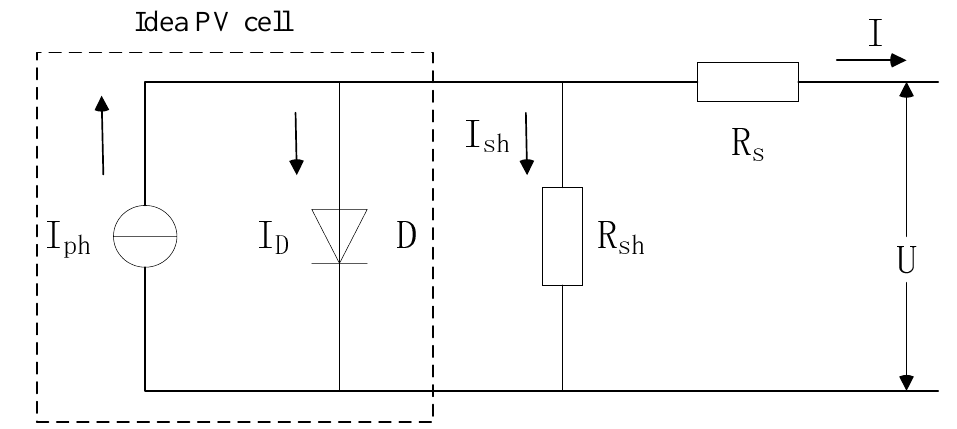
Figure 1. MATLAB Simulink Photovoltaic system model.